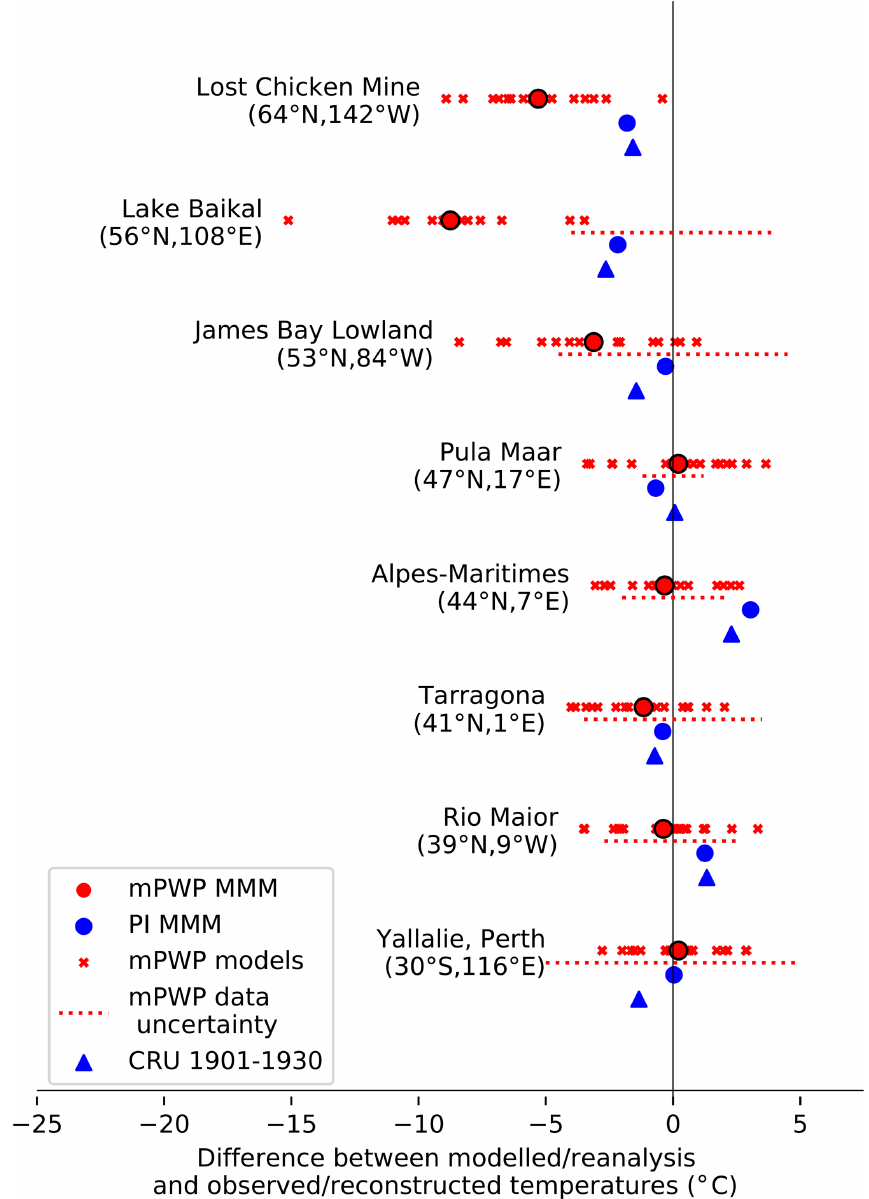
Figure 2. Blue circles shows the difference between MMM preindustrial MAT and modern observations at the site. The blue triangle shows the difference between the CRU MAT for years 1901–1930 and the modern observations at the site, representing an estimate of the error caused by comparing a single modern data point to a preindustrial model grid box. The red circle shows the difference between MMM mPWP MAT and the MAT reconstructed from the proxy; red crosses show the anomalies for the individual models. The red dotted line shows the uncertainty in the data reconstruction (where